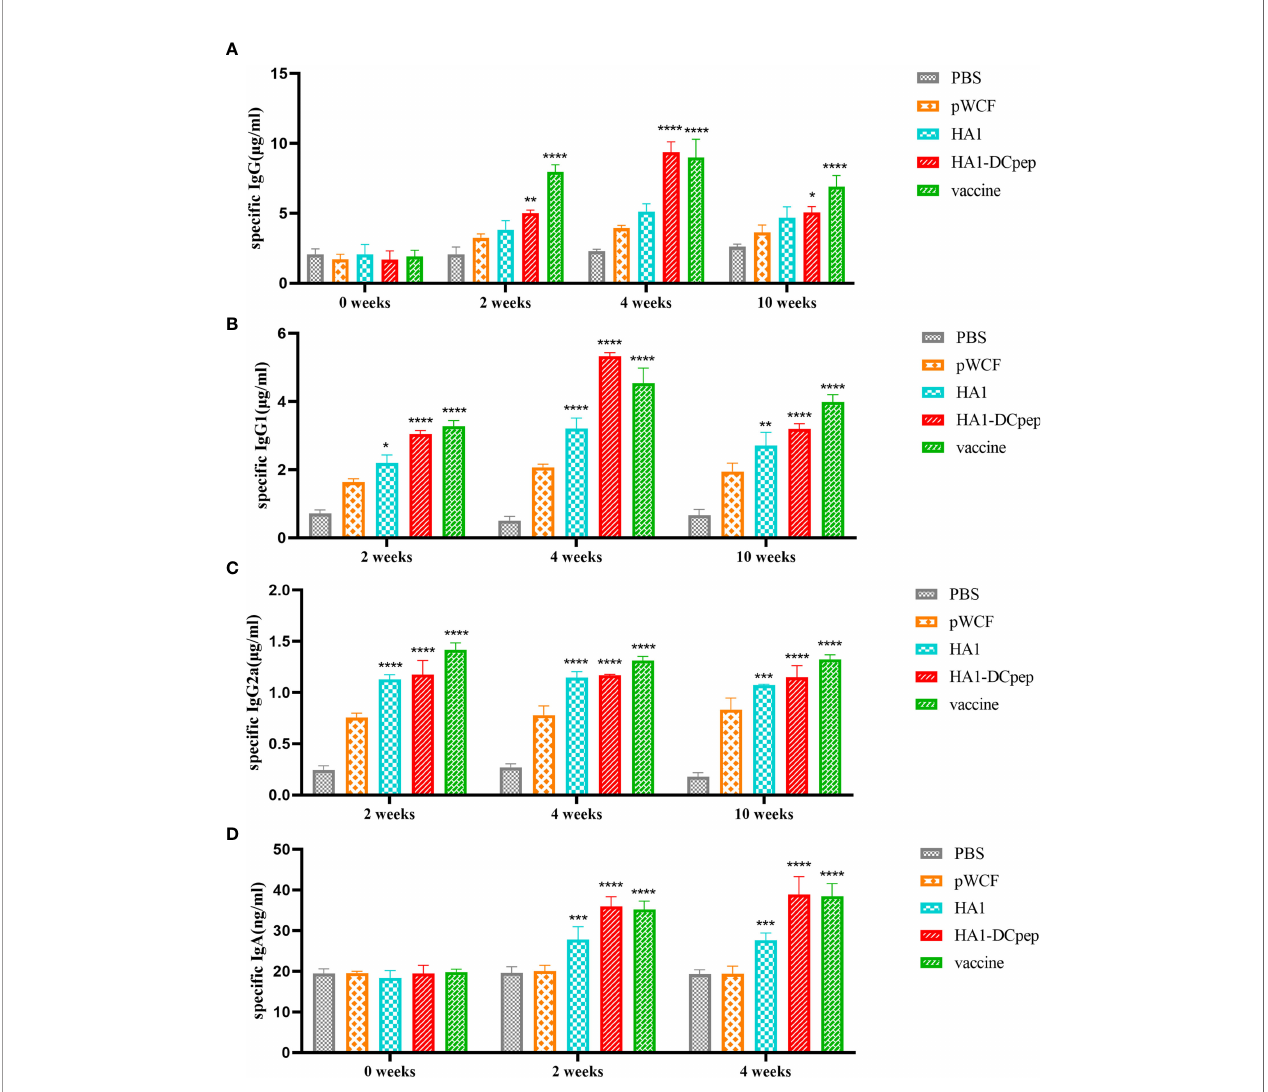
FIGURE 6 | Recombinant L. plantarum increase speci fi c antibody levels. The expression levels of speci fi c IgG antibodies in the serum at weeks 0 (before immunization), 2 (2 weeks after primary immunization), 4 (2 weeks after booster immunization) and 10 (10 weeks after primary immunization), (A) IgG1 (B) and IgG2a (C) antibodies in the serum at weeks 2, 4 and 10 and IgA (D) antibodies in the feces of mice at weeks 0, 2 and 4 were measured by ELISA. In the same period, HA1, HA1-DCpep and vaccine groups were compared with the pWCF “ empty vector ” group. Statistical signi fi cance was assessed by two-way ANOVA (n = 3 mice per group). *P < 0.05; **P < 0.01; ***P < 0.001; ****P <